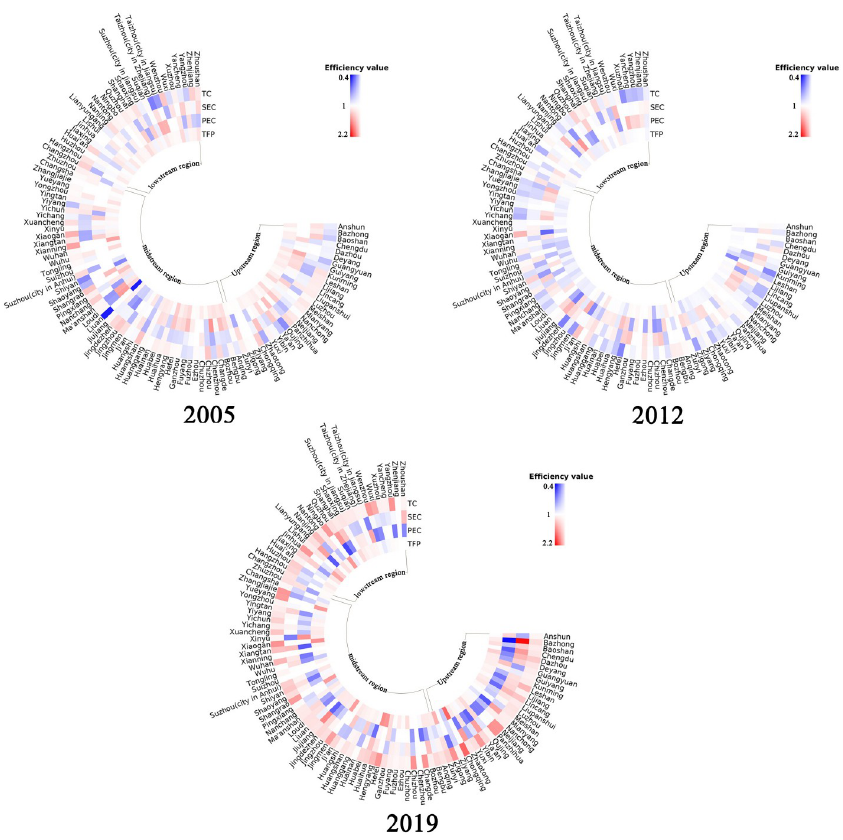
Fig 3. Spatial distribution of urban economic development TFP indicators and decomposition